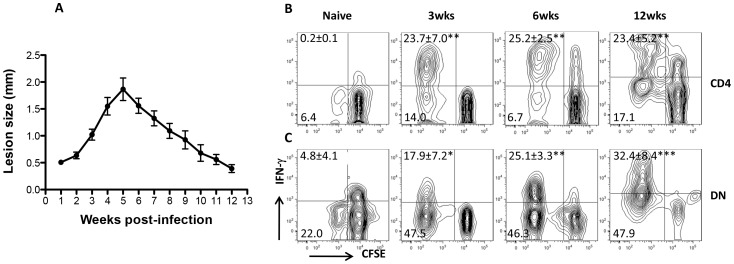
DN T cells are activated during primary L. major infection.C57BL/6 mice were infected with 2×106
L. major and lesion progression was monitored weekly with calipers (A). At indicated times, infected mice were sacrificed and pooled splenic and dLN T cells were co-cultured with L. major-infected BMDCs for 5 days and cell proliferation and IFN-γ production by CD4+ (B) and DN (C) T cells were analyzed by flow cytometry. Results are representative of 2–3 independent experiments (n = 3–4 mice) with similar results. *, p<0.05; **, p<0.01; ***, p<0.001 infected vs. naïve (uninfected) controls.